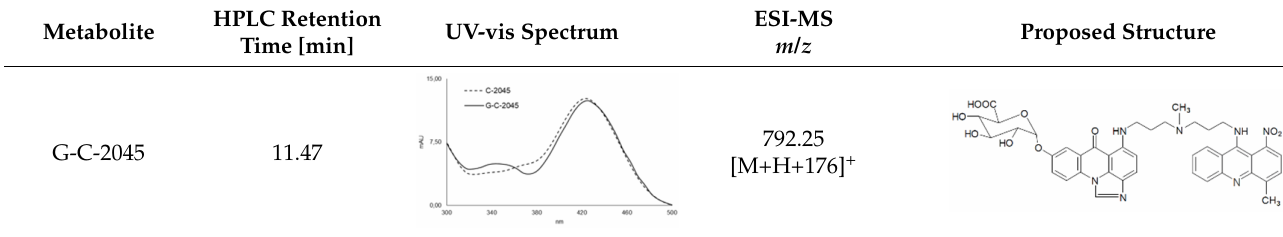
Figure 8. HPLC analysis of the reaction mixtures after 120-min incubations of 0.05 mM C-2045 with the selected recombinant isoenzymes of UGT1A family: UGT1A1, UGT1A9 and UGT1A10 (1 mg/mL) and 5 mM UDPGA as the cofactor. The comparison of the related glucuronide peak areas. Table 5. The structure of glucuronidation product obtained after C-2045 metabolism with human recombinant isoenzymes UGT1A1, UGT1A9 and